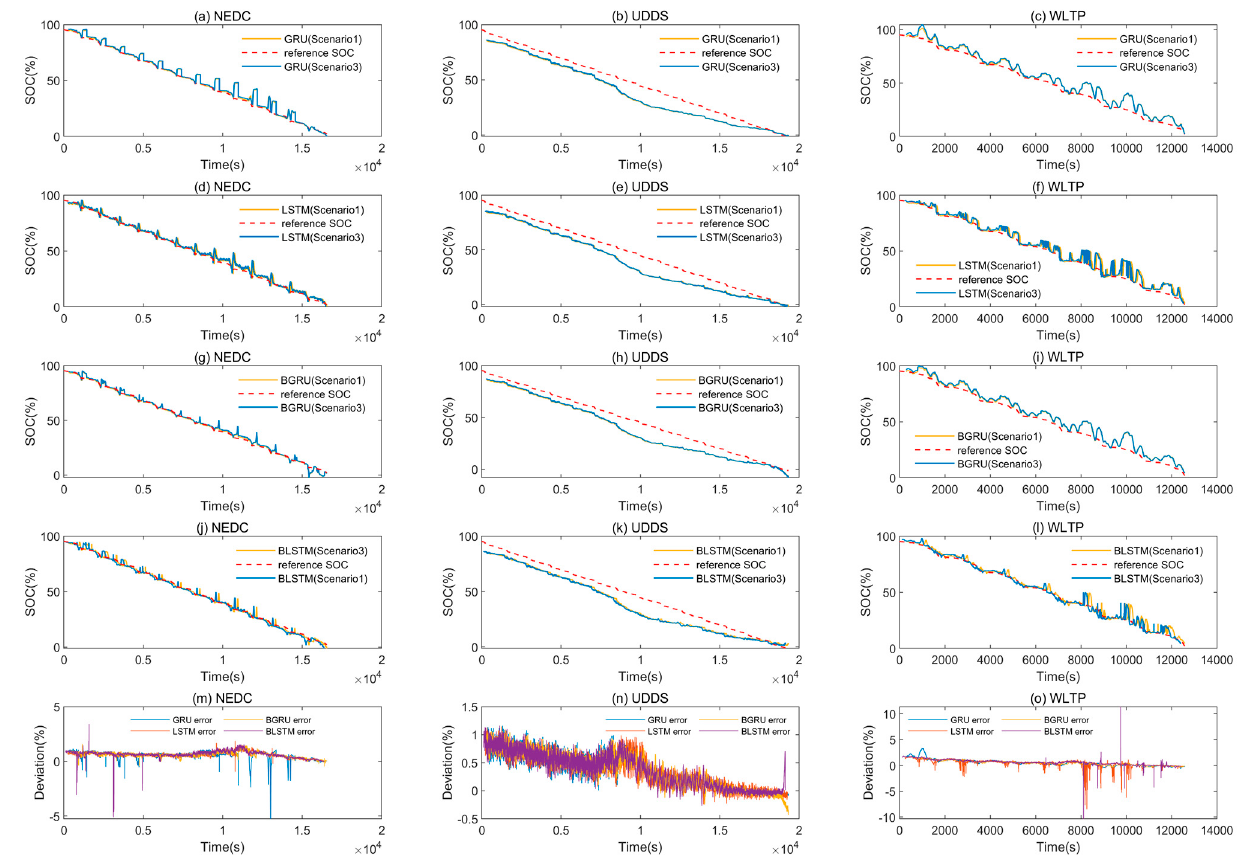
Figure 6. SOC estimation results of scenario 3: ( a – c ) SOC estimation using the GRU-based model; ( d – f ) SOC estimation using the LSTM-based model; ( g – i ) SOC estimation using the BGRU-based model; ( j – l ) SOC estimation using the BLSTM-based model; ( m – o ) SOC estimation errors of four RNN-based models; ( m – o ) deviations between SOC estimations with and without noise; ( a , d , g , j , m ) test under NEDC conditions; ( b , e , h , k , n ) test under UDDS conditions; ( c , f , i , l , o ) test under WLTP